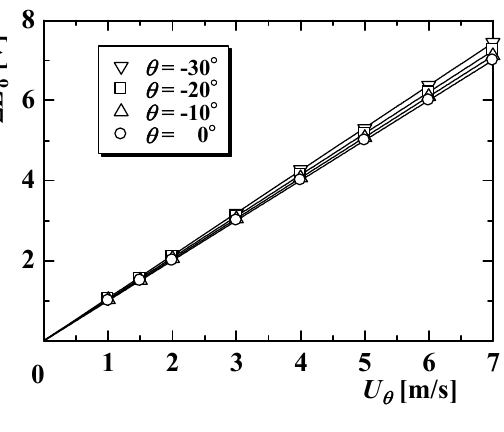
Fig. 9 Calibration of Σ E o versus U θ